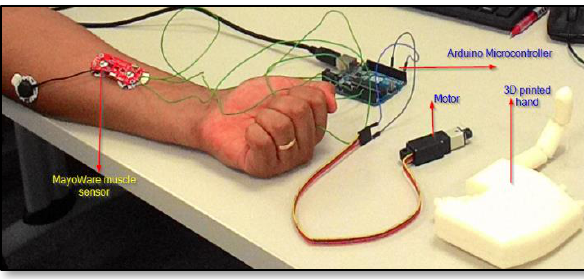
Figure 9. – Overall layout of the